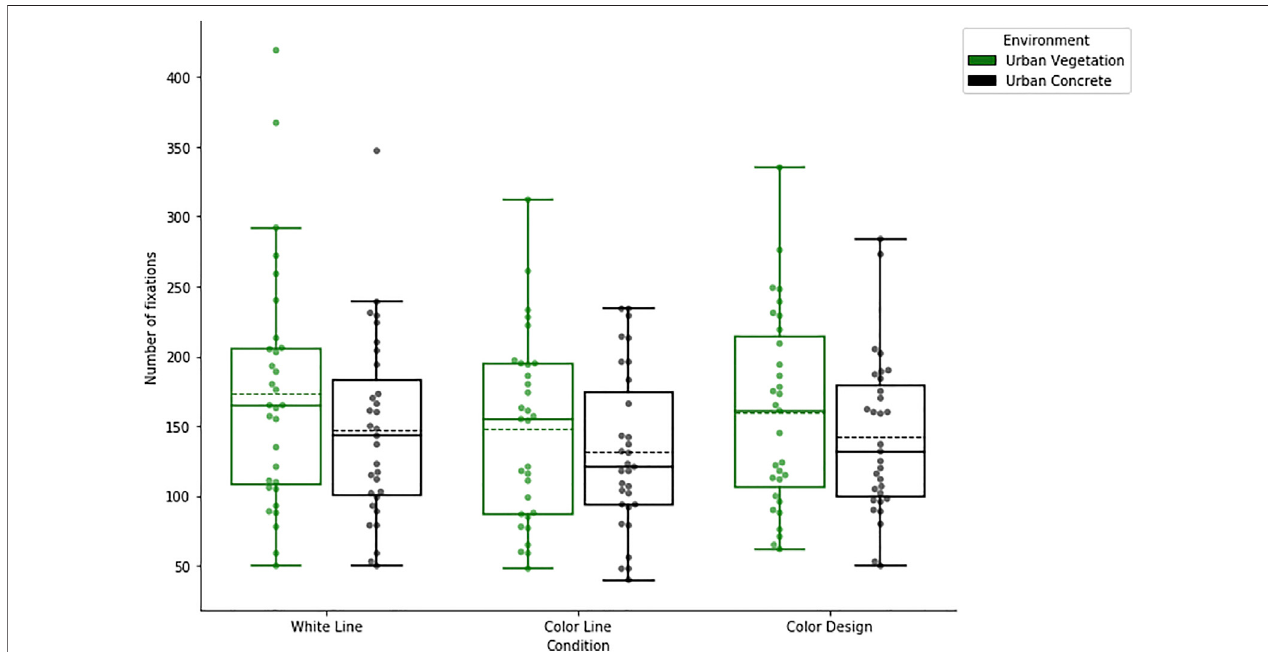
FIGURE 10 | Bar charts illustrating the impact of Environment (Concrete vs . Vegetation) on the number of gaze fi xations during spontaneous walking in the six urban virtual environments.